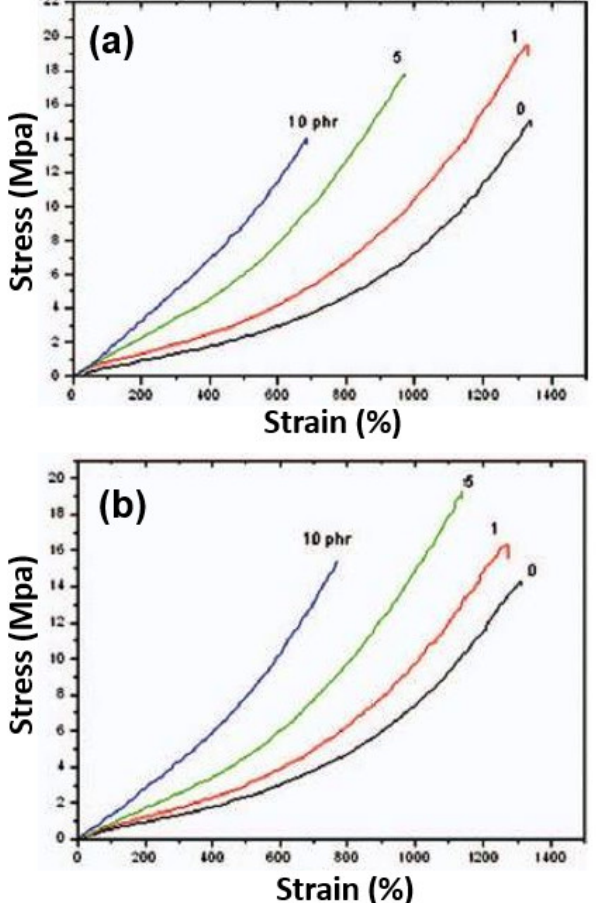
Figure 5. Stress-strain curves of NR composites with ( a ) CNT and ( b ) phenol functionalized CNT. Reproduced with permission from [62], Copyright Wiley, 2012.